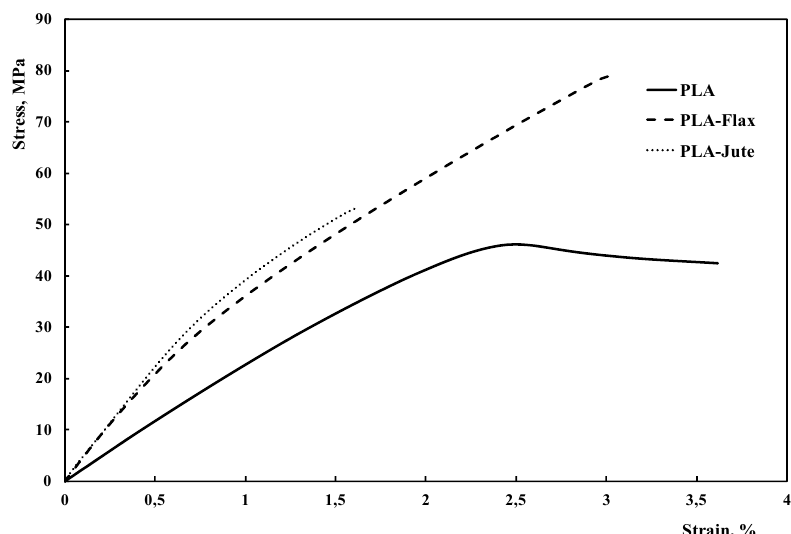
Figure 1. Stress ‐ strain curves of PLA and related composites. Figure 1. Stress-strain curves of PLA and related